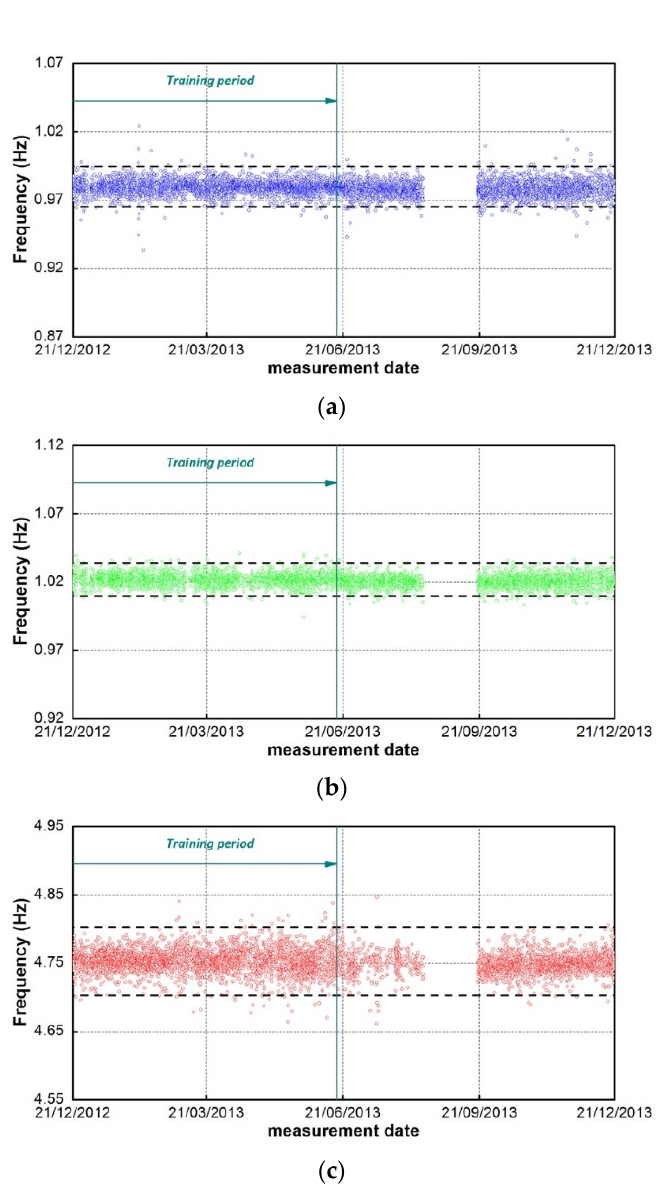
Figure 16. Change in the cleaned natural frequency (Auto-Regressive model with eXogenous input) induced by the seismic event of 21/06/2013: ( a ) Mode B 1 ; ( b ) Mode B 2 ; and ( c ) Mode T 1 .